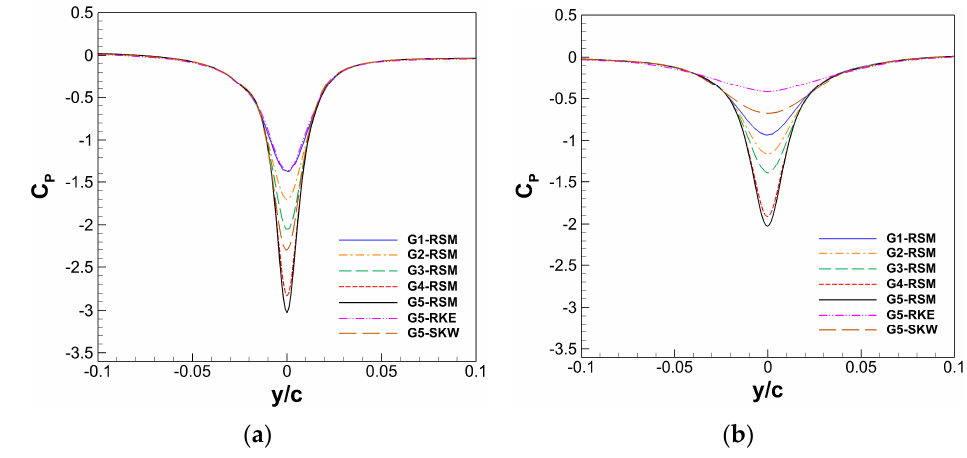
Figure 8. Pressure coefficient profiles across the tip vortex core: ( a ) x/c = 0.2; ( b ) x/c = 1.0.